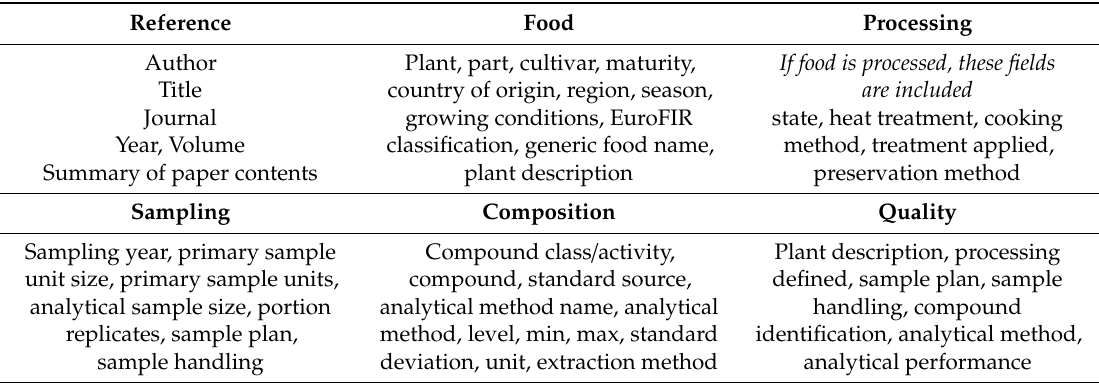
Table 1. eBASIS data entry